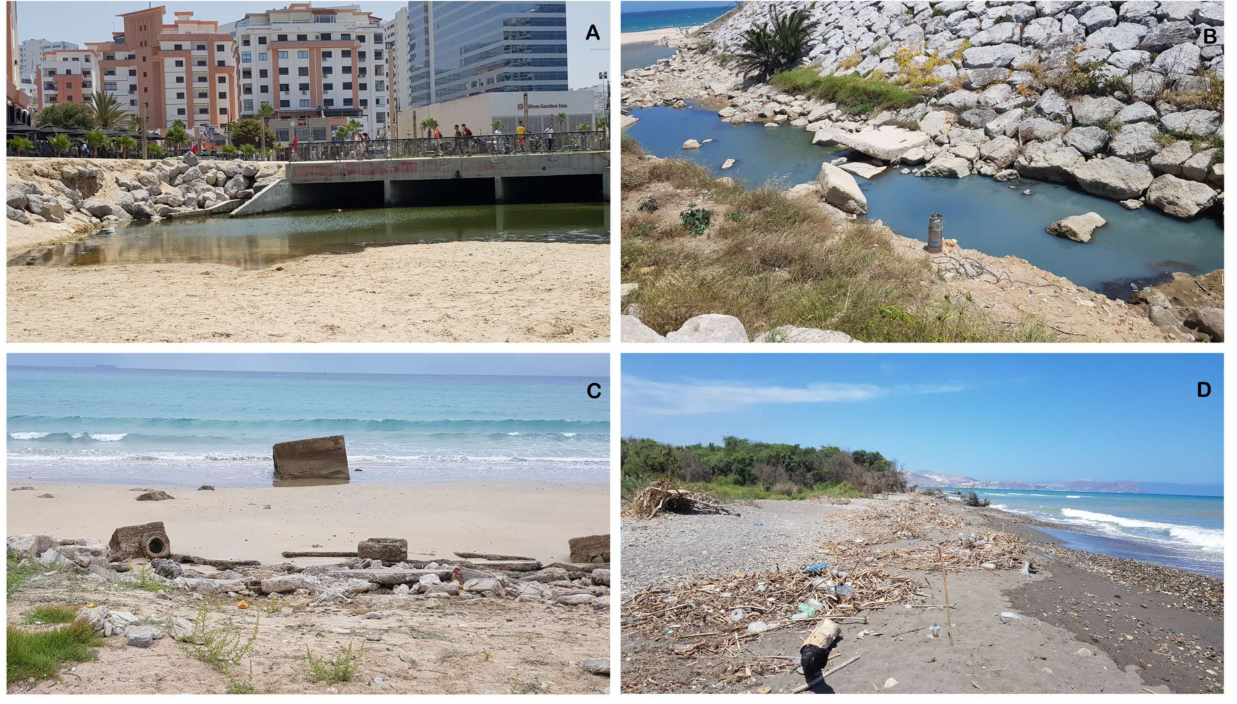
Figure 9. Examples of litter and sewage negatively impacting the beauty of coastal scenery (( A ), Tangier Municipal; ( B ), Marqala; ( C ), Tangier Malabata; ( D ),